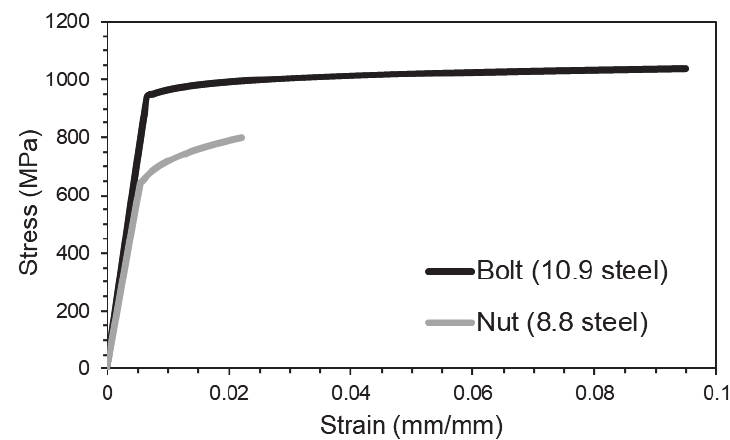
Figure 7. Stress–strain curves for grade 10.9 and 8.8 steels .